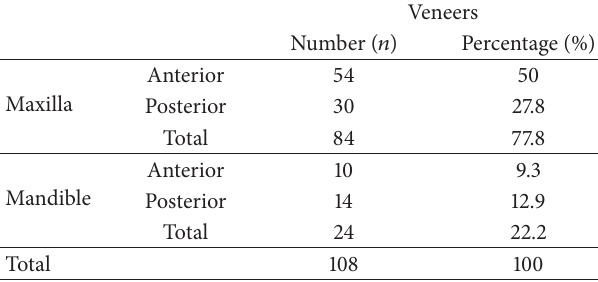
Table 2: Distribution of porcelain laminate veneers according to location.